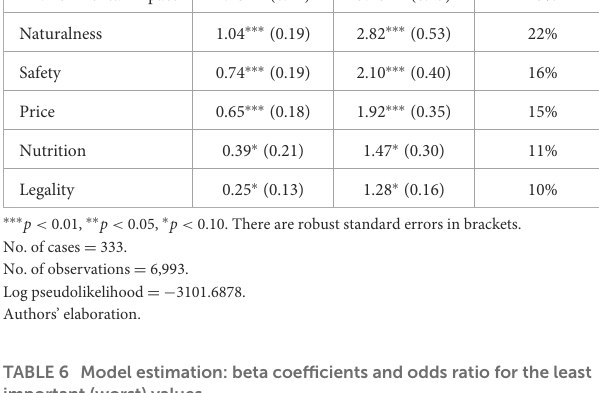
TABLE 6 Model estimation: beta coefficients and odds ratio for the least important (worst) values.